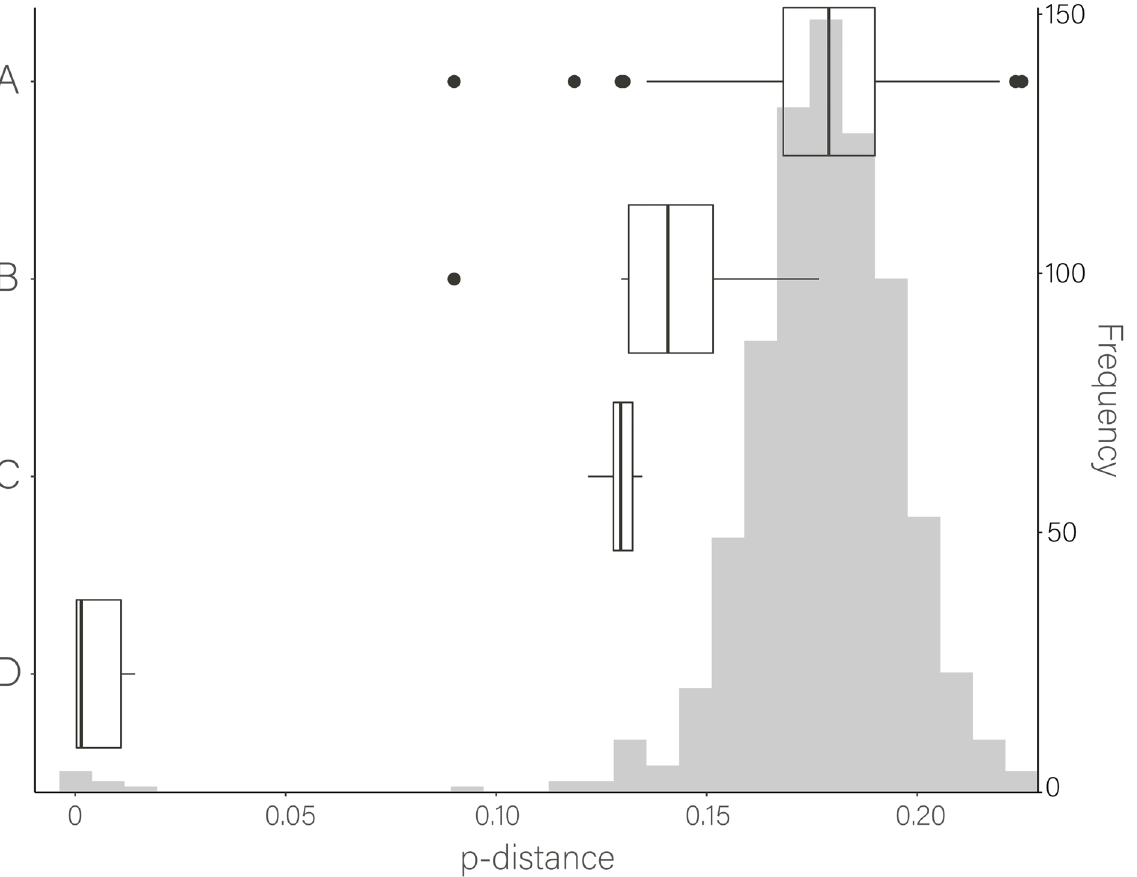
Fig. 10. COI p-distance (uncorrected) frequency histogram (in gray) and boxplots comparing p-distances between A . Entomobryinae species. B . Entomobryinae sister species. C . Willowsia nigromaculata (Lubbock, 1873) (France and Toronto, Canada) and W. neonigromaculata sp. nov (USA and Brockville, Canada) clades (inter-specific distances). D . Lineages within the same W. nigromaculata or W. neonigromaculata sp. nov. clade (intra-specific